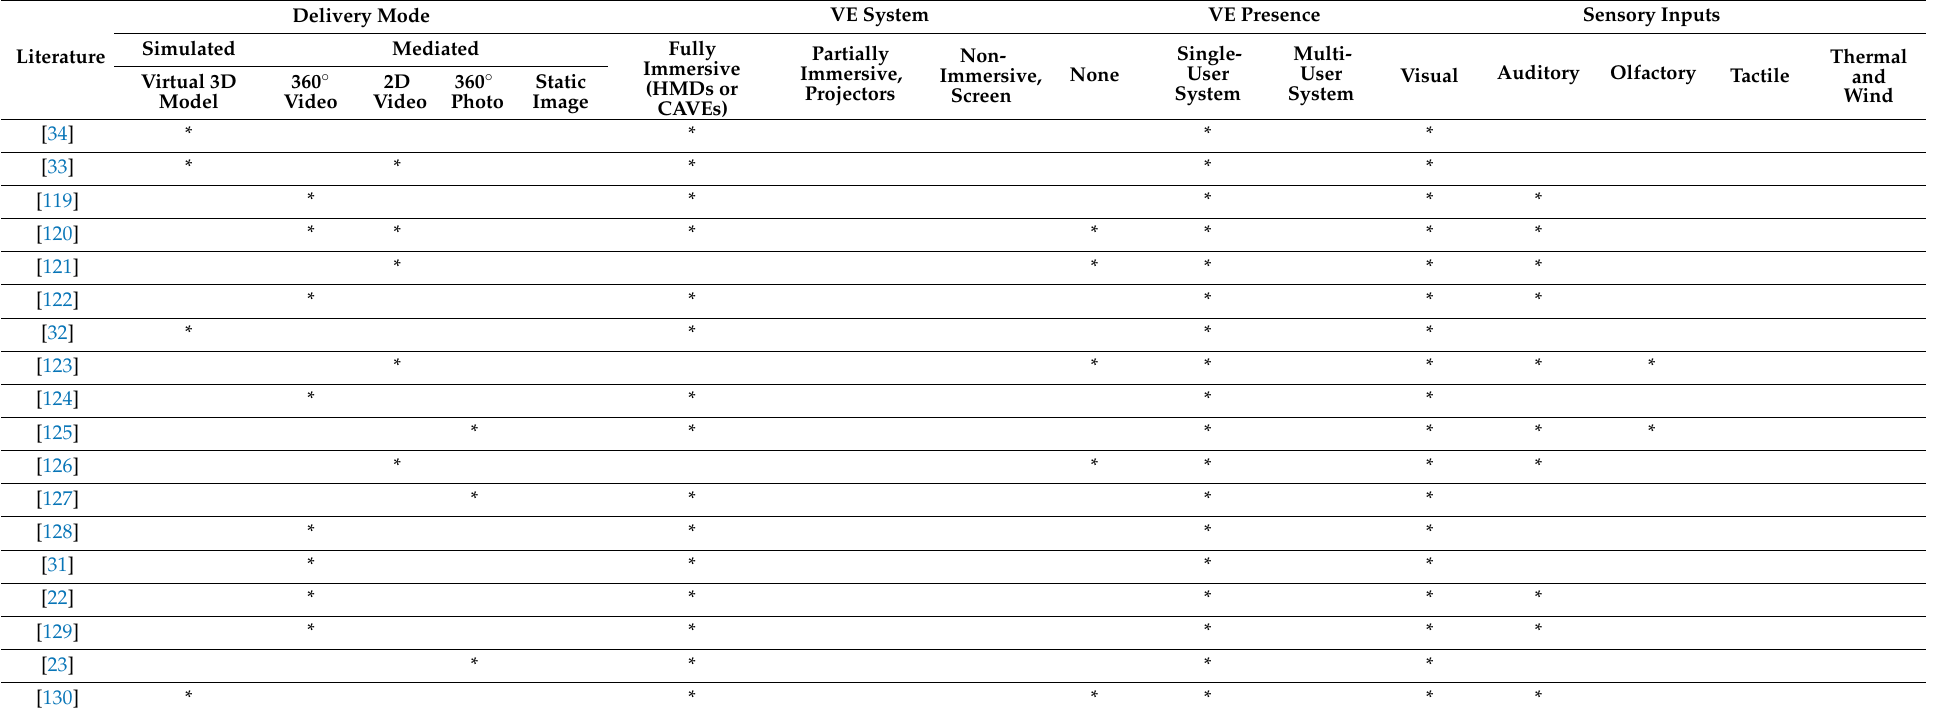
Table A4. Classification of the reviewed studies employing virtual natural environment (factors